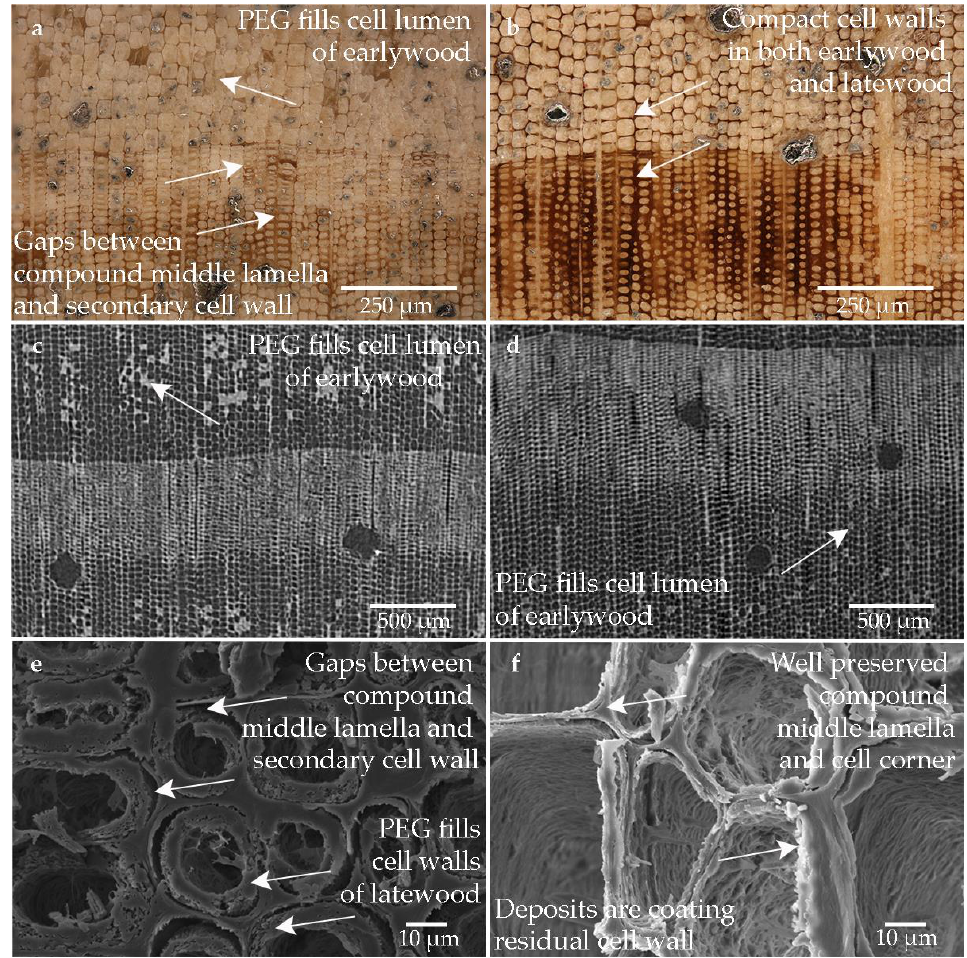
Figure 8. Microscopic wood structure of sample conserved with PEG 400, PEG 1500 and PEG 4000 and freeze-drying (Pi1-PEG3) ( a ) RLM image from the heavily degraded area; ( b ) RLM image from the low degraded area; ( c ) CT image of the cross section of the heavily degraded sample; ( d ) CT image of the cross section of the low degraded sample; ( e ) SEM image of the latewood tracheids; ( f ) SEM image of the earlywood tracheids in the heavily degraded area.